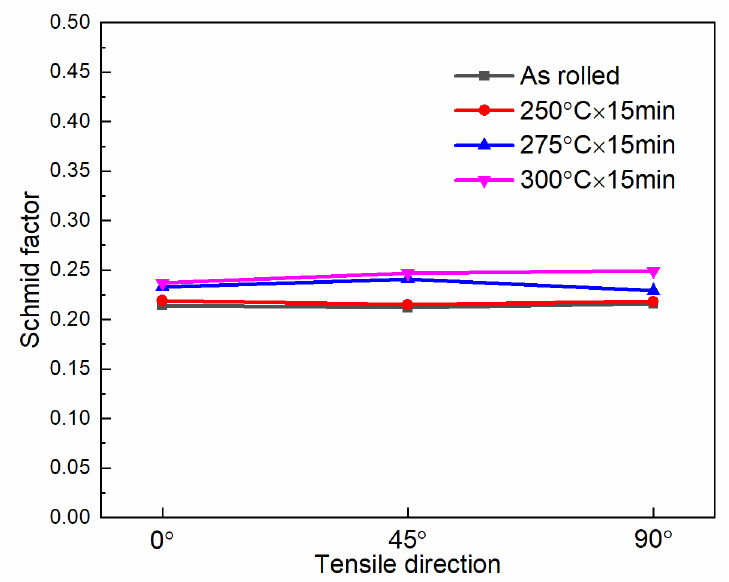
bers of twins. Due to the incompatibilities between the deformation of the twinned inter-